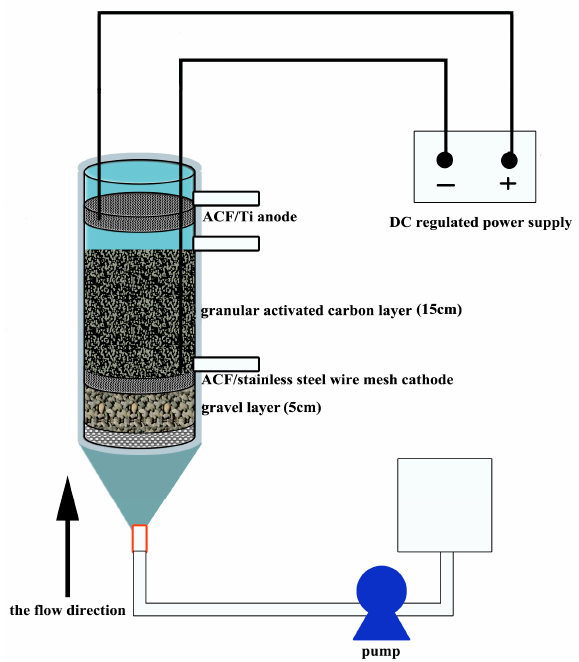
Figure 1. Schematic diagram of the reactor.